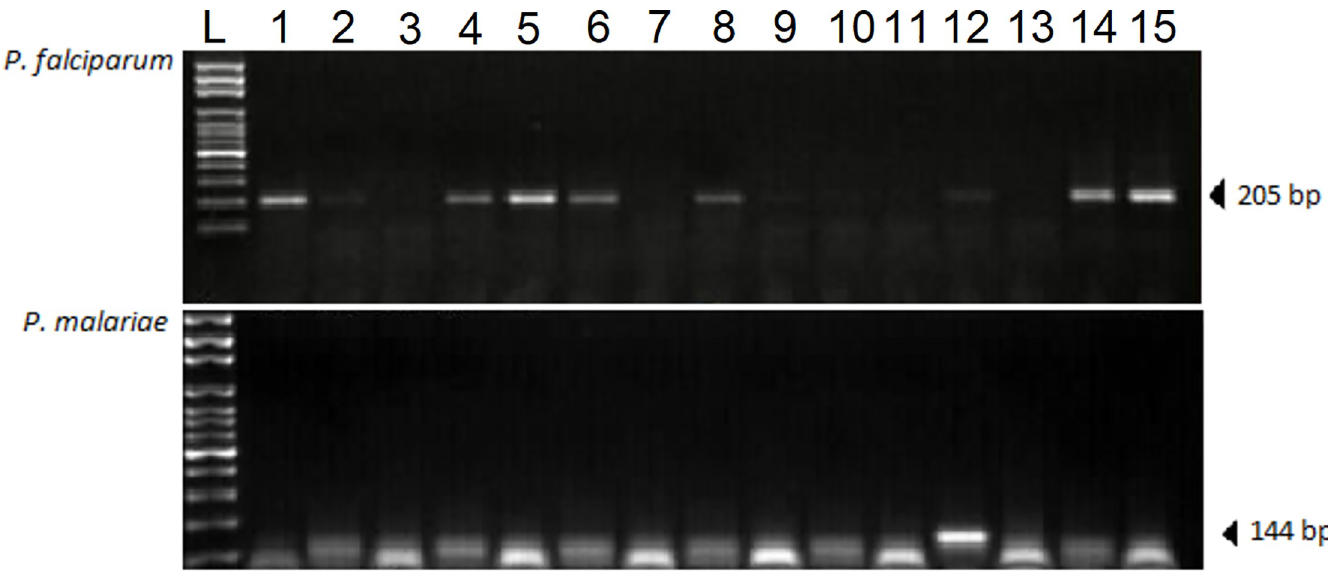
Fig 1. Agarose gel electrophoresis showing nPCR products under UV light. The top panel shows representative results of the P . falciparum -specific nested PCR. Lanes 1, 4, 5, 6, 8, 12, 14, and 15 contain the positive 205 bp PCR products expected. The bottom panel shows representative results of the P . malariae -specific nested PCR. Lane 12 contains the positive 144 bp PCR product expected. Smaller bands are likely due to low DNA concentration in those samples. L represents the molecular